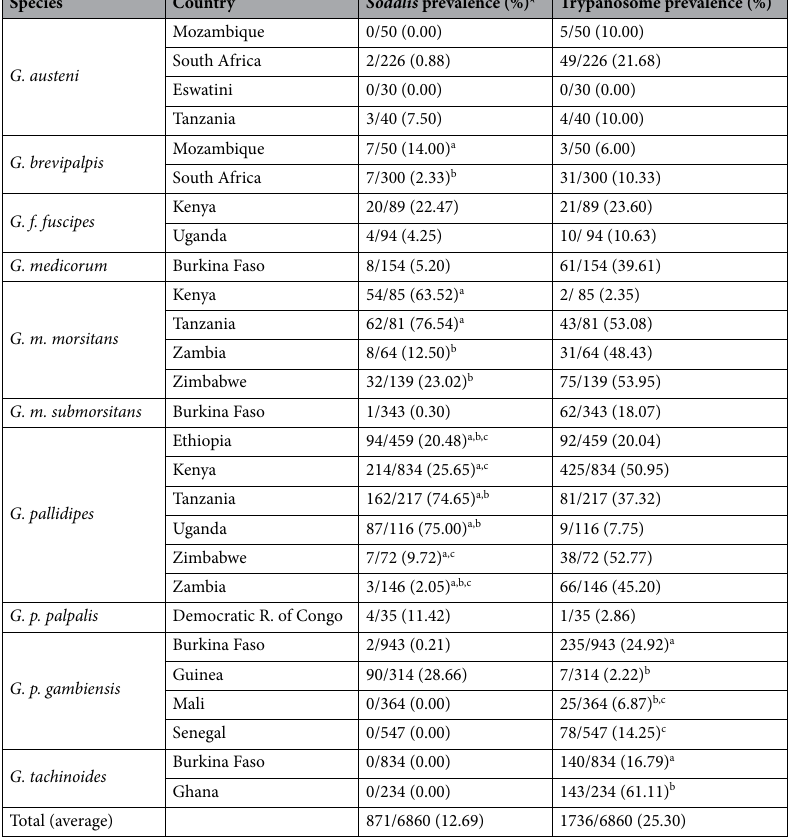
Table 3. Global prevalence of Sodalis and trypanosomes in tsetse samples analyzed per country and tsetse species. * Values indicated by the same lower-case letter do not differ significantly at the 5%